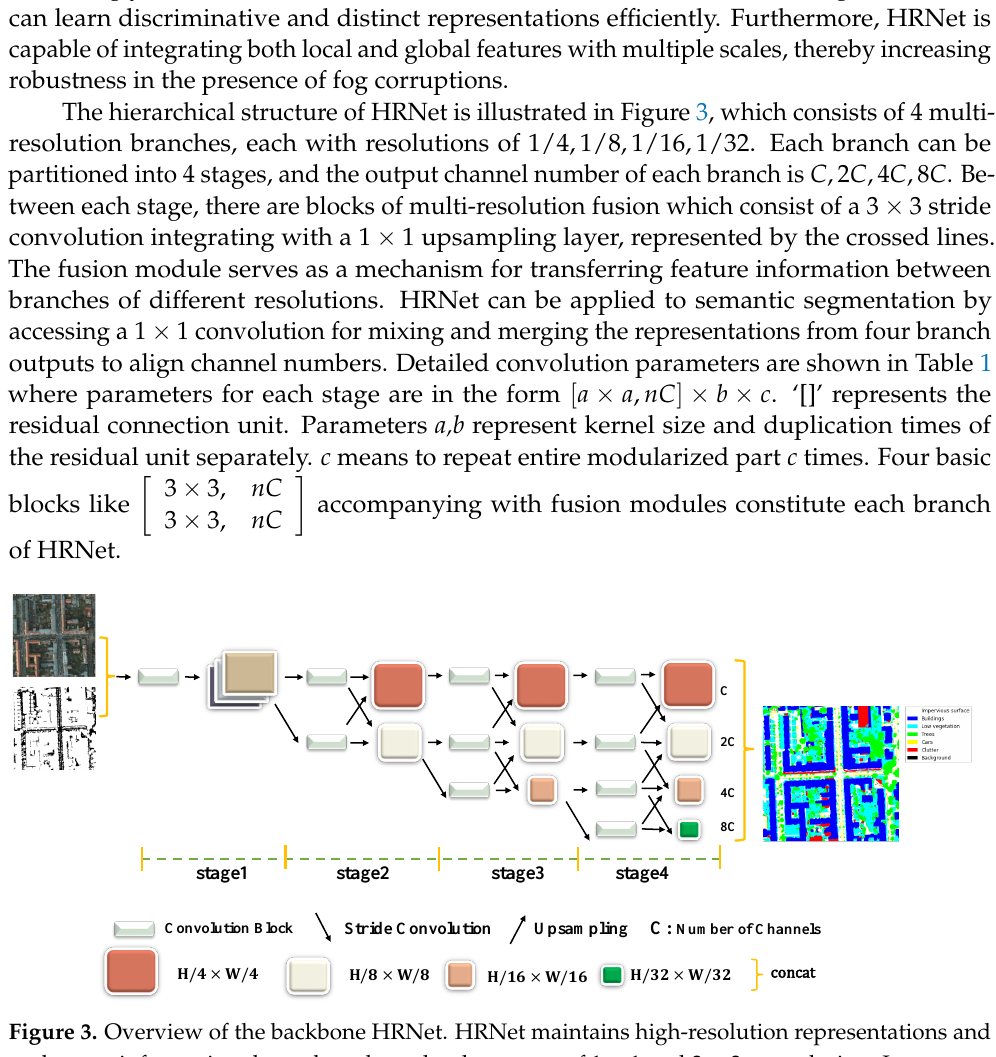
Figure 3. Overview of the backbone HRNet. HRNet maintains high-resolution representations and exchanges information throughout branches by means of 1 × 1 and 3 × 3 convolution. It can cope well with intra-class heterogeneity and multi-scale issues in RSIs with